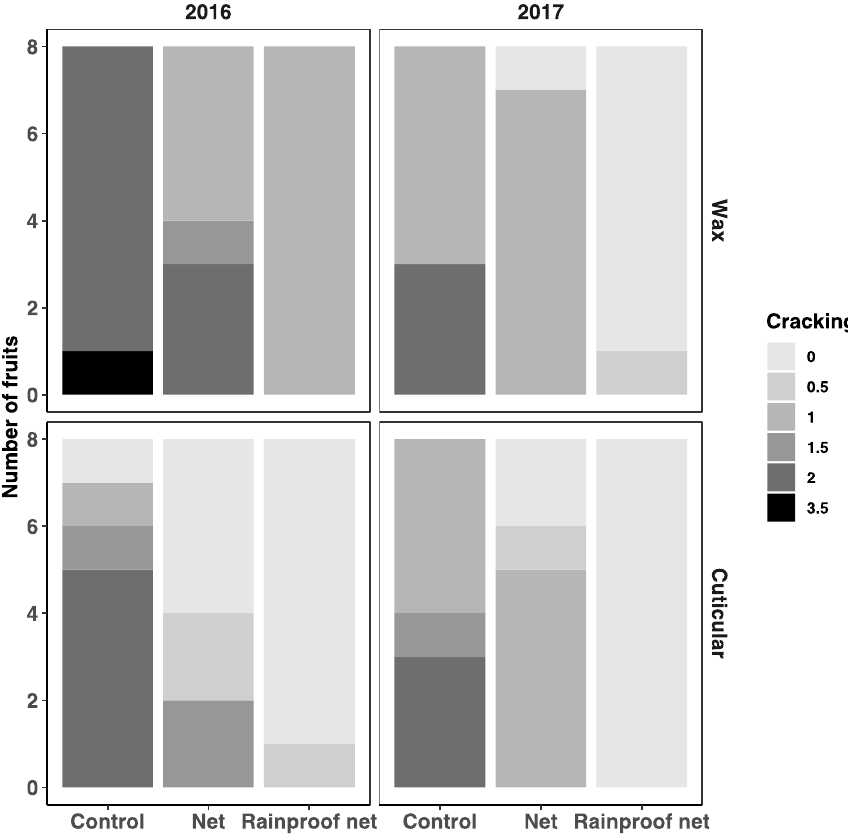
Figure 4. Cuticular and superficial wax cracking score at harvest on fruits from row units covered with nets or rainproof nets compared to unnetted row units. The graph represents the number of fruits for each cracking score, based on the median of 10 scores per fruit.